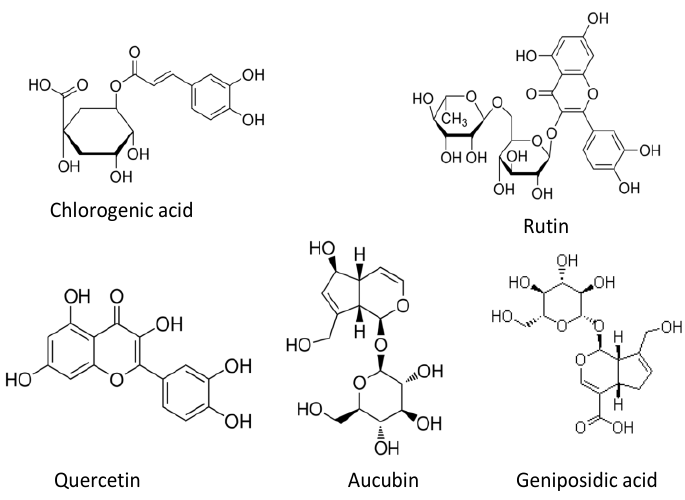
Figure 1. Structure of compounds in EU